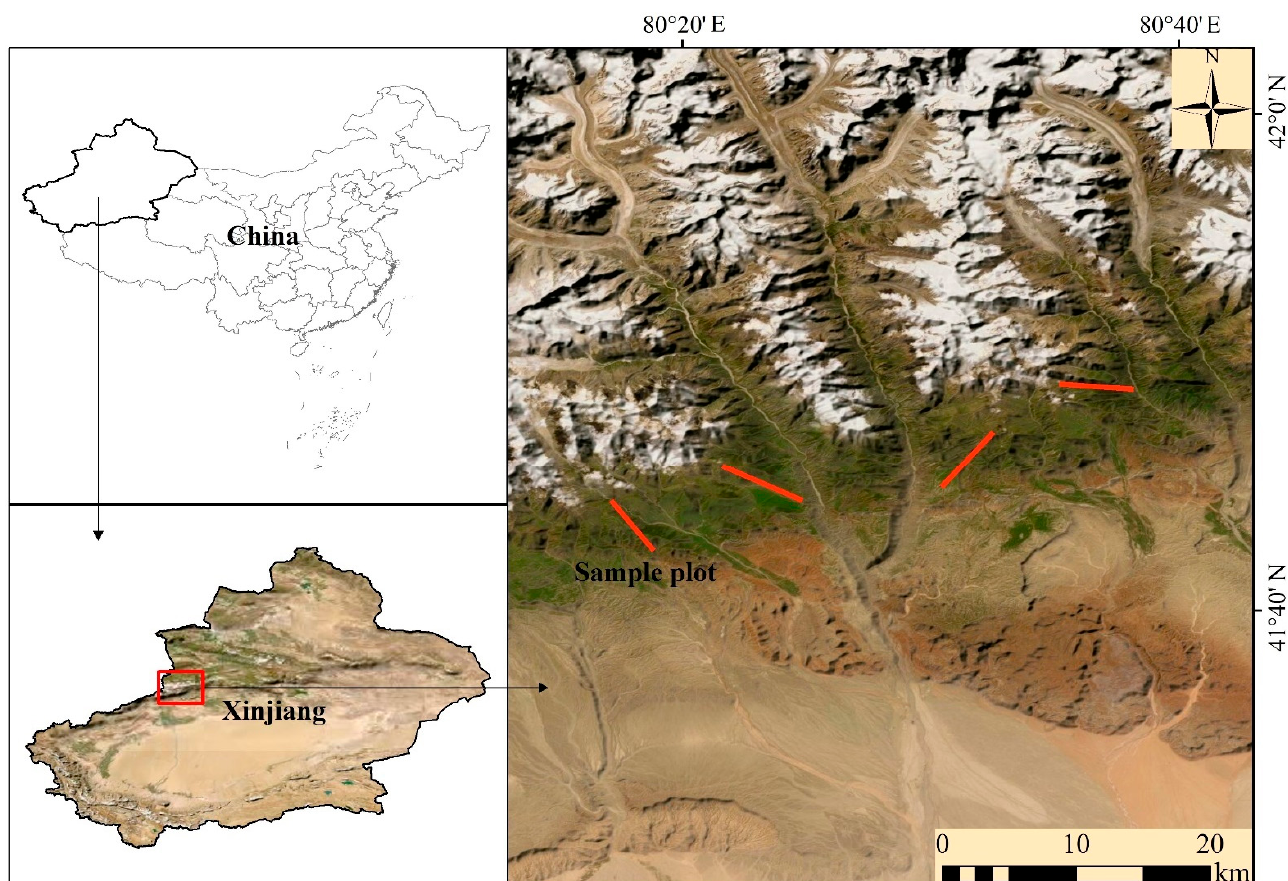
Figure 1. Sketch map of the study area.